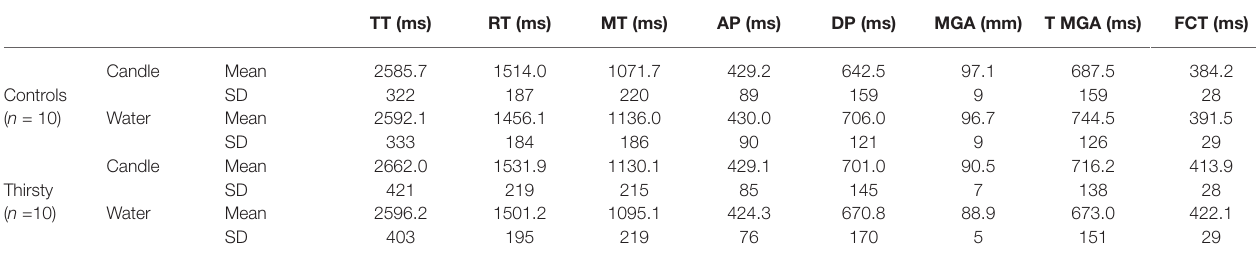
TABLE 1 | Mean and SD for each kinematic parameter for control and thirsty groups when they grasped glasses filled with candle or water. TT